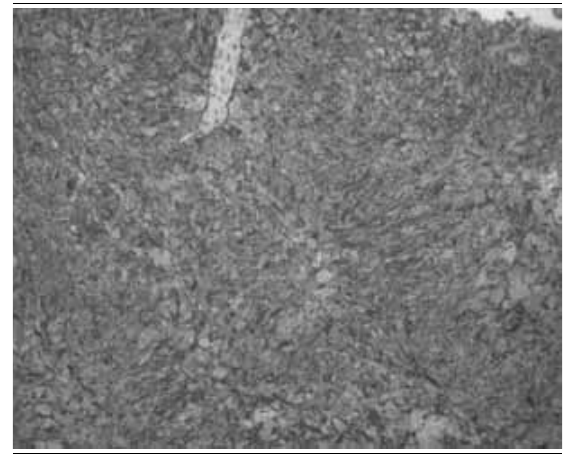
figurE 4 – GBM showing positive immunoexpression for GFAP, streptavidin- biotin, 100× GBM: glioblastoma; GFAP: glial fibrillary acidic